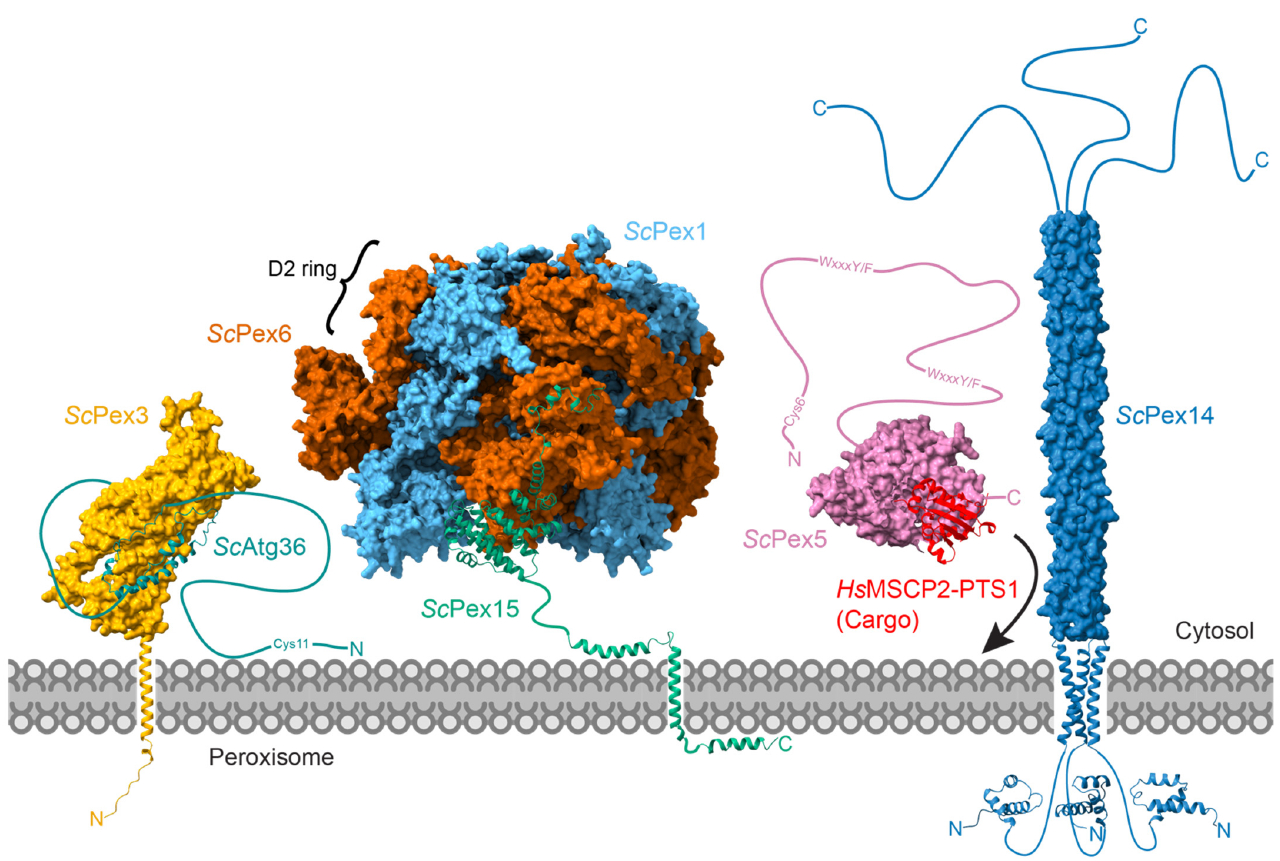
Figure 6. Putative Pex1/Pex6 substrates (cytoPex15, Pex5, and Atg36) have disordered tails (curved lines) capable of accessing the Pex1/Pex6 D2 pore. Pex1/Pex6 is recruited to the peroxisome mem- brane by Pex15 (models based on EMDB-6359; PDB 5VXV; Alphafold2 multimer). In vitro, the truncated cytosolic domain of Pex15 is a Pex1/Pex6 substrate. Pex5 bound to a PTS1-tagged protein (model based on Hs PEX5 bound to MSCP2 PDB: 2C0L; Alphafold2 Sc Pex5 AF: P35056) embeds in the DTM, primarily composed of Pex5 bound to Pex14 (modeled from EMDB-12047 [10.2 Å]; Alphafold2 AF: P53122). Pex1/Pex6 is then thought to extract mono-ubiquitinated Pex5 from the membrane. Atg36 interacts with Pex1/Pex6 indirectly through Pex3 and Pex15 (models based on Alphafold2 multimer). Pex1/Pex6 prevents Atg36 phosphorylation, though the mechanism is unclear. Figures made with ChimeraX 1.3